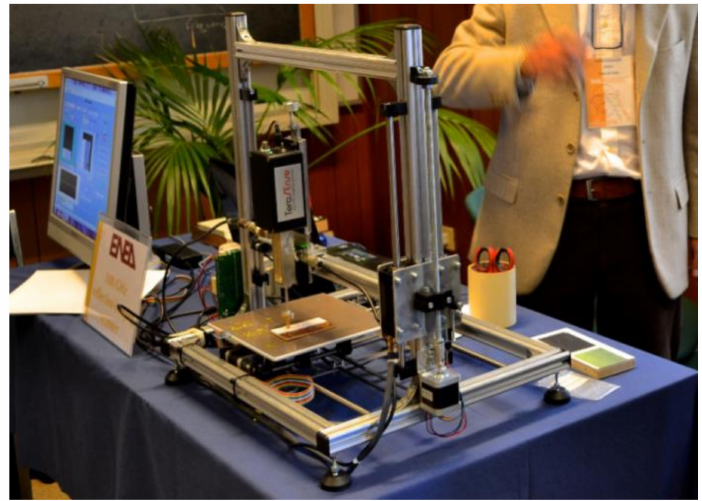
Figure 12. First prototype of a THz 3D imaging scanner.